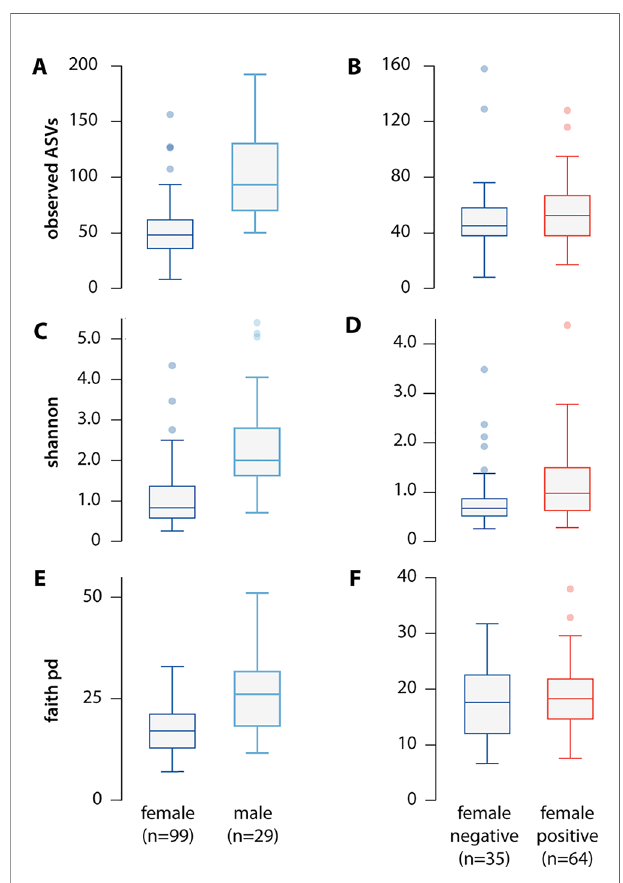
FIGURE 2 | Alpha diversity of the microbiome differs signi fi cantly between females and males, but not between B. burgdorferi- infected and uninfected ticks. We measured alpha diversity using three different metrics, including (A) the count of observed ASVs by sex (p = 1.01e-10) and (B) by infection status (p = 0.30), (C) the Shannon index, a non-phylogenetic alpha diversity metric, by sex (p = 6.45e-10), and by (D) infection status (p = 0.02), and (E) Faith's Phylogentic Diversity index, a phylogenetic alpha diversity metric by sex (p = 6.45e-10) and (F) by infection status(p = 0.56). While infection status was signi fi cant using the Shannon Index, this difference disappeared after removing B. burgdorferi reads from the analysis (p =